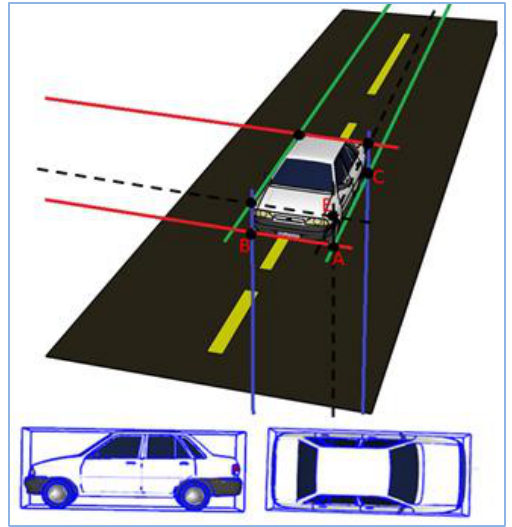
Figure 2. Formation of the vehicle bounding box.